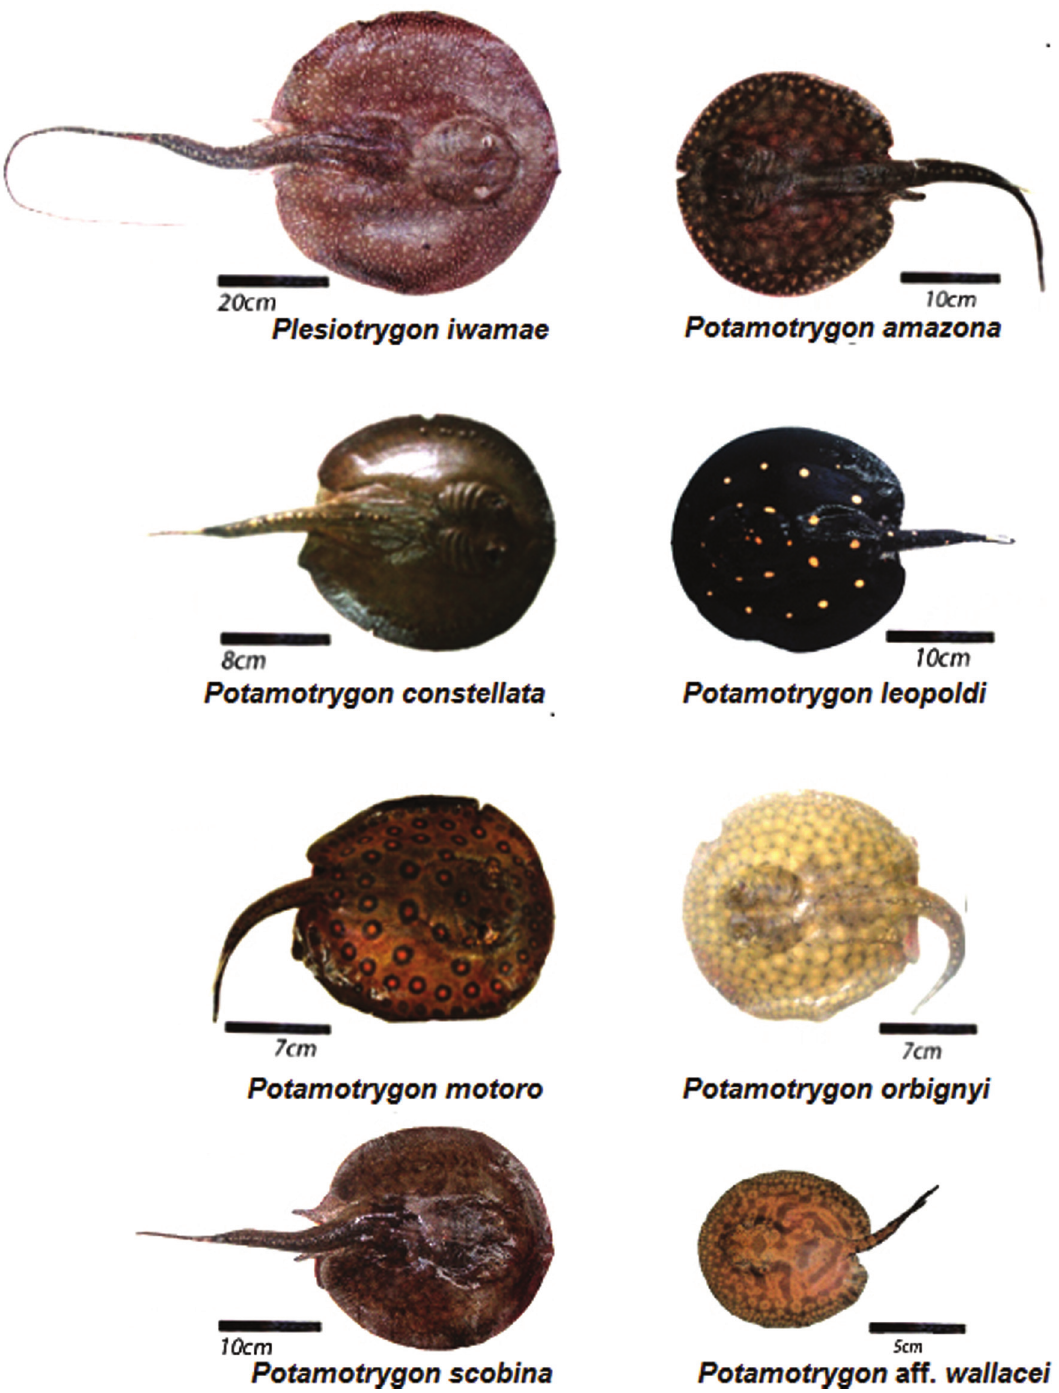
Figure 1 - Stingray species analyzed in the present